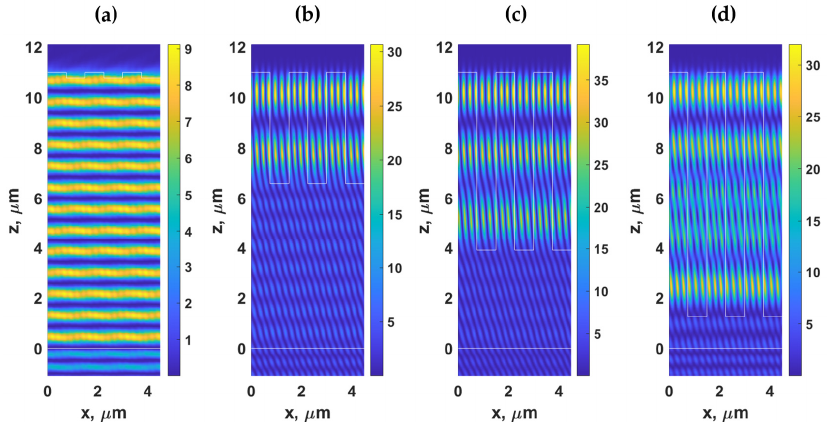
Figure 6. H 2 y field distribution calculated using RCWA for the gratings with λ g of 1.5 µ m, F.F. of 0.5, d of 11 µ m, and ( a ) d g of 0.24 µ m, ( b ) d g of 4.42 µ m, ( c ) d g of 7.11 µ m, and ( d ) d g of 9.75 µ m, when illuminated by TM polarized light at 685 nm and the n 0 sin θ 0 of 1.37.